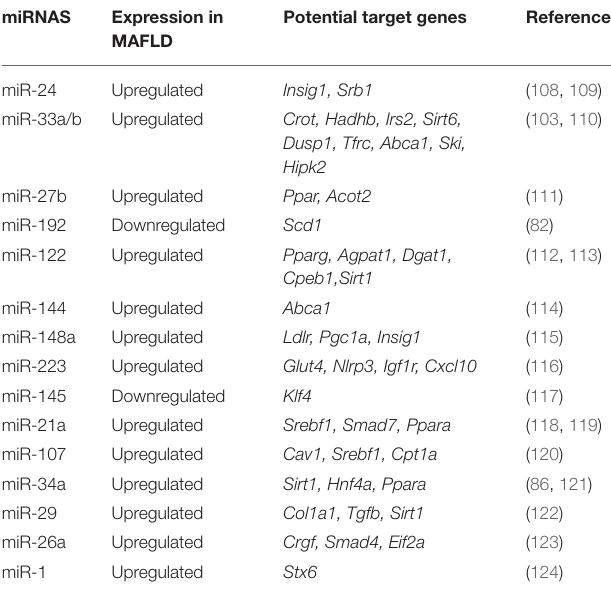
TABLE 1 | miRNAs implicated in crucial key process in MAFLD and their potential target genes. miRNAS